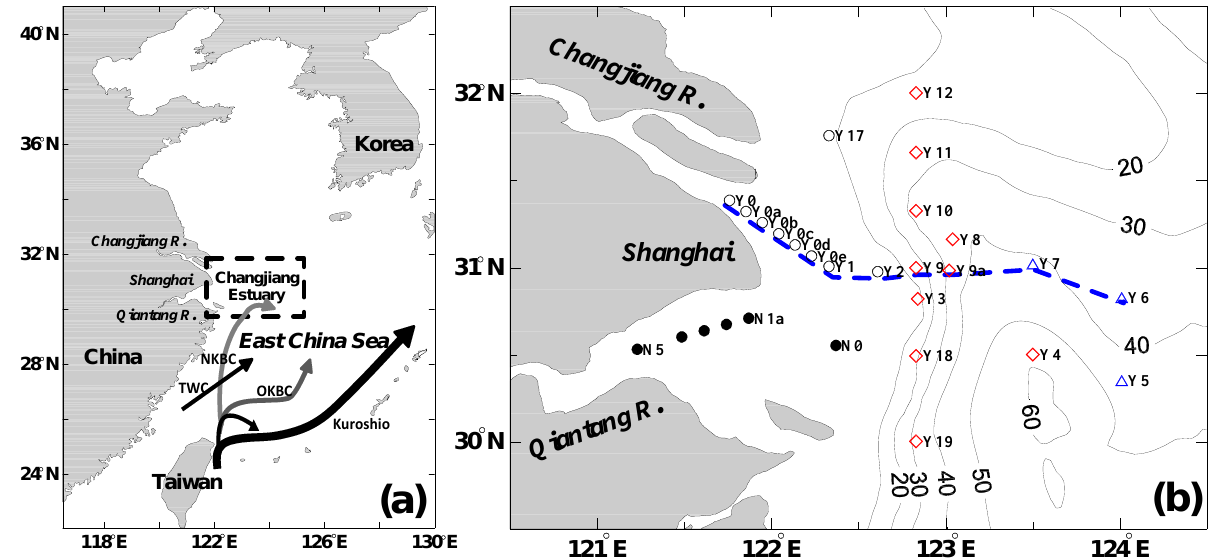
Fig. 1. Location maps of the Changjiang estuary and the East China Sea (a) and sampling stations with bathymetry (m, solid curves) off the Changjiang River mouth (b) . The stations influenced by turbidity are represented by open circles. Red diamonds and blue triangles represent upwelling-influenced and plume fringe stations, respectively. The CJ transect (dashed line) comprises estuary stations from Y0 through Y1, then Y2, Y9, Y9a, Y7, and